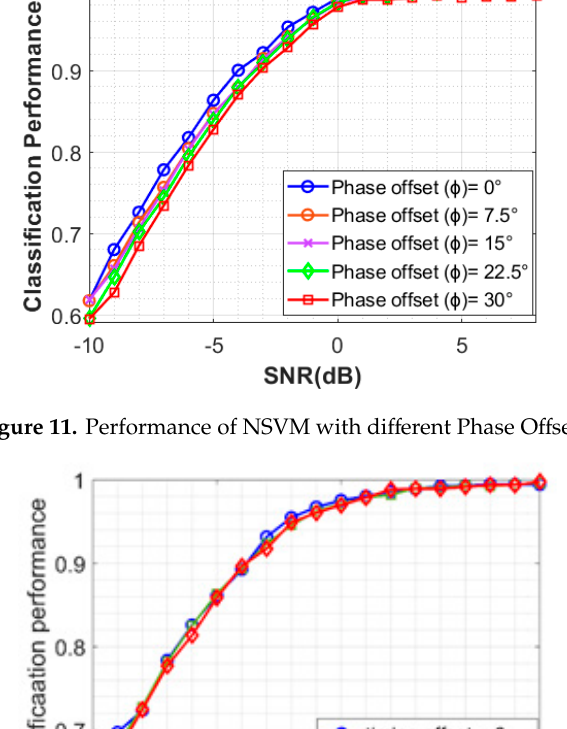
Figure 10. Performance of NSVM with Different Carrier Frequency Offset in received signal.